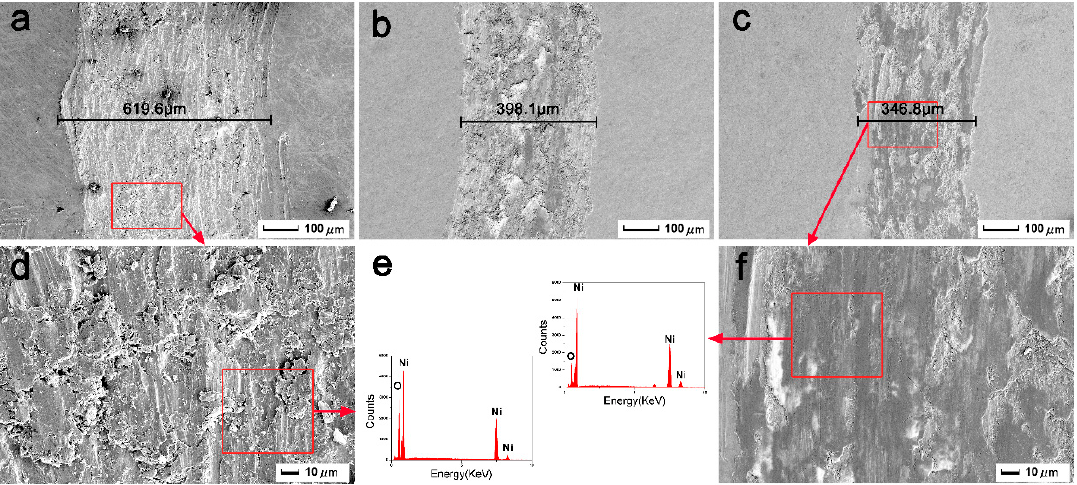
Figure 8. SEM wear profile of the ( a , d ) initial pure Ni, and ( b ) 10-pulse, ( c , f ) 20-pulse HCPEB-irradiated Cr–Ni sample surfaces; ( e ) EDS line.